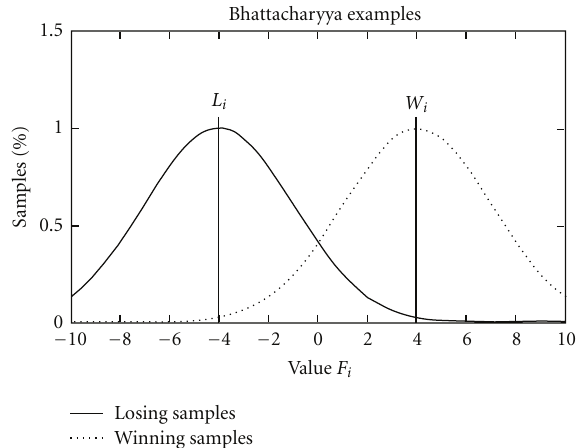
Figure 4: A visualization of the Bhattacharyya coe ffi cient (BC) on feature F i .